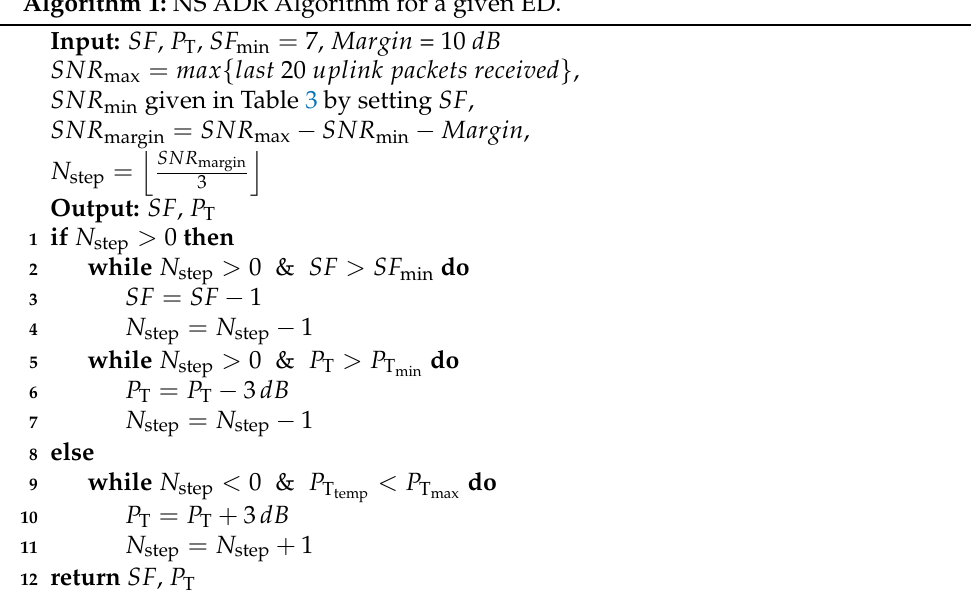
Algorithm 1: NS ADR Algorithm for a given ED.